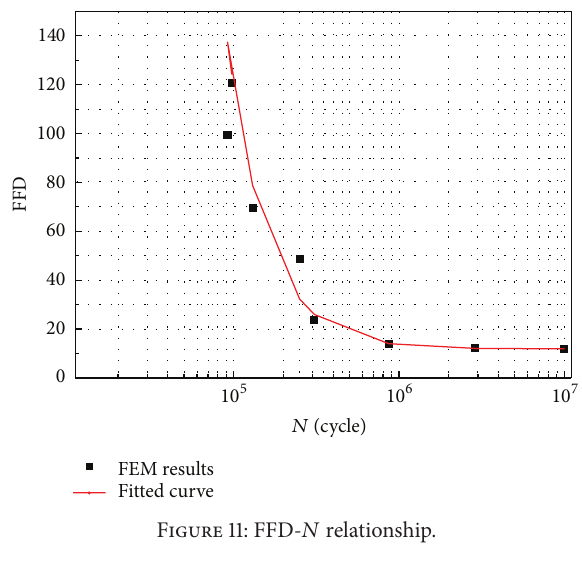
Figure 11: FFD- 𝑁